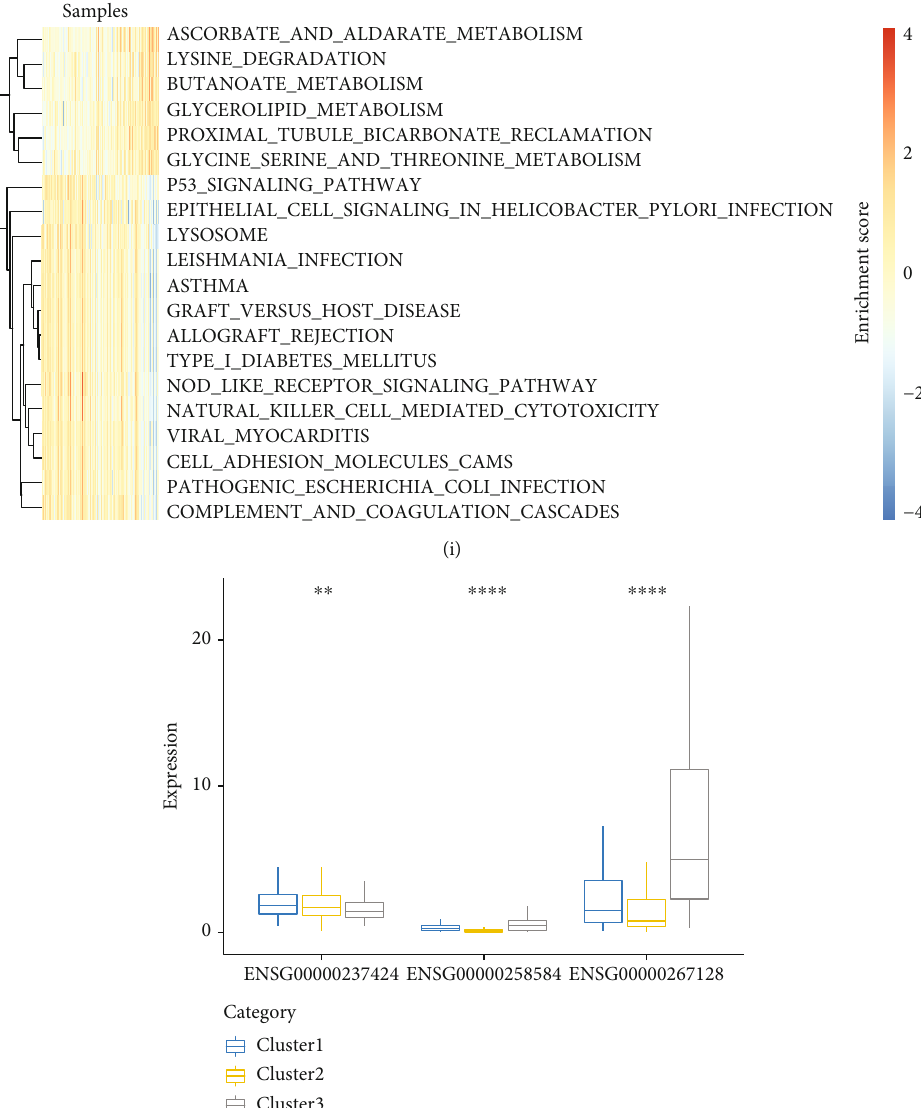
Figure 7: Three lncRNAs were associated with prognosis in thyroid cancer. (a – c) ROC curve of FOXD2-AS1, FAM181A-AS1, and RNF157- AS1 in the TCGA dataset. (d – f) KM survival curve of FOXD2-AS1, FAM181A-AS1, and RNF157-AS1 in the TCGA dataset. (g – i) KEGG pathway analysis of FOXD2-AS1, FAM181A-AS1, and RNF157-AS1 in the TCGA dataset. (j) The expression and distribution of three lncrnas were di ff erent in three molecular